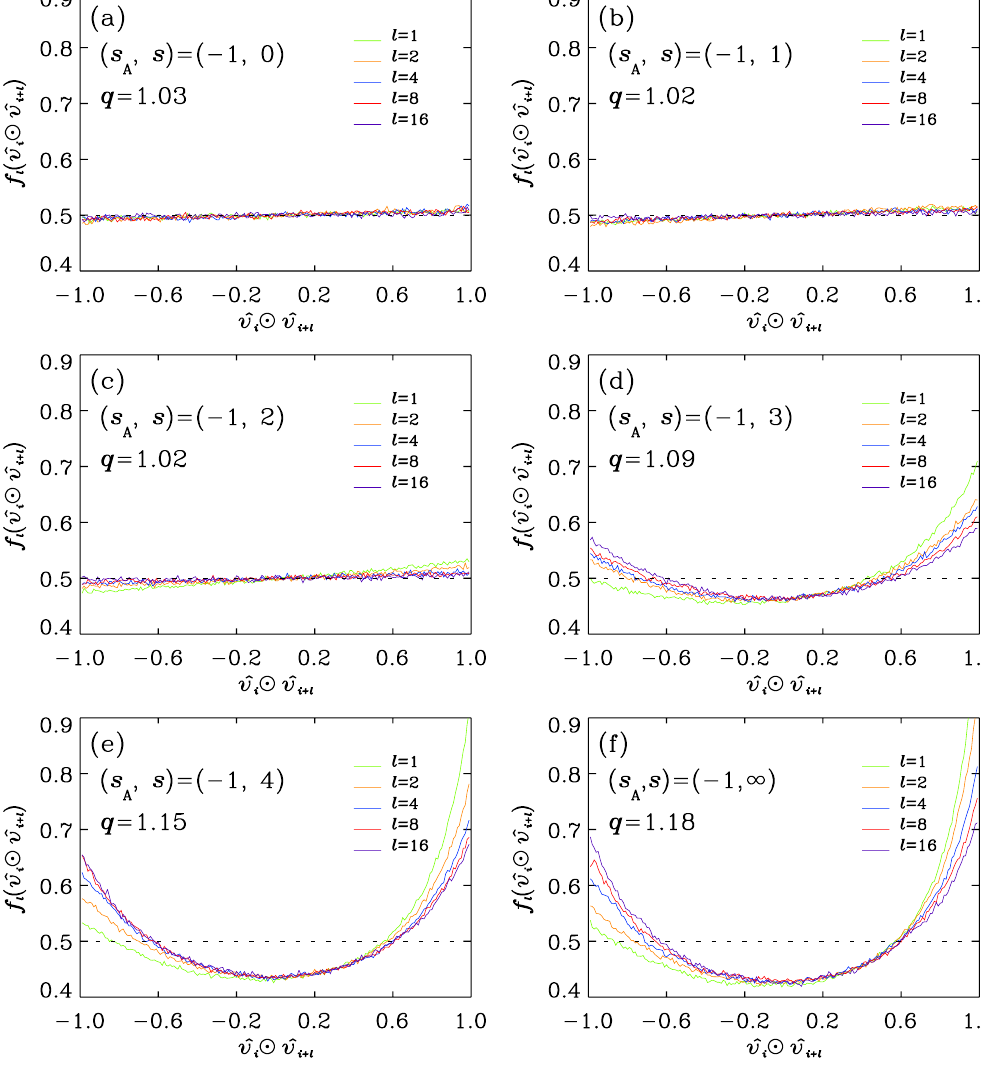
parallel (marked by subscript ‘ ‖ ’) and in two perpendicular directions (marked by subscripts ‘ ⊥ 1’ and ‘ ⊥ 2’, respectively) in reference to the curved backbone coordinates, corresponding to ˆ b , ˆ u and ˆ w , respectively (Fig. 1(a)). In the limit → ⊥ T T , we have j E ( v ) → 4 π v 2 and Eq. (8) converges to the isotropic case, Eq. (5). The values listed for the fitted curves in Fig. 3 show that, for those systems with ⋅ ˆ ˆ f v b ( ) (Fig. 2(a)) deviating from the uniform distribution, their T ⊥ 1 and T ⊥ 2 are significantly larger than T (Fig. 3(d–f)). The polymer chains, under ‖ the dominance of backbones, are internally in non - equilibrium situations. The fitting by EMB (Eq. (8)) is certainly better than that by the isotropic Maxwell-Boltzmann distribution (IMB) (Eq. (5)) and is comparable with the result by Eq. (4). Equation (8) suggests a scenario of thermal motion in a ‘tube’-like string 37, 64–66 . Note that, while both Eqs (4) and (8) are two-parameter fitting functions, the anal- ysis using Eq. (4) does not require the knowledge of backbone frames and provide a convenient way to reveal the stability of the system, by simply fitting to obtain a scaled distribution function covering all instants of time. Besides, the validity of expression Eq. (4) 67 does not rely on the statistical independence among the components of velocity, along the longitudinal and in the transverse directions. In previous studies 51, 52 , it has been shown that the fitting by Eq. (4) and, thereof, by Eq. (6) for sequences of microscopic states, do identify effectively the non-equilibrium ‘quasi-steady’ states, generated by untamed numerical noises. In this study, we retained the same